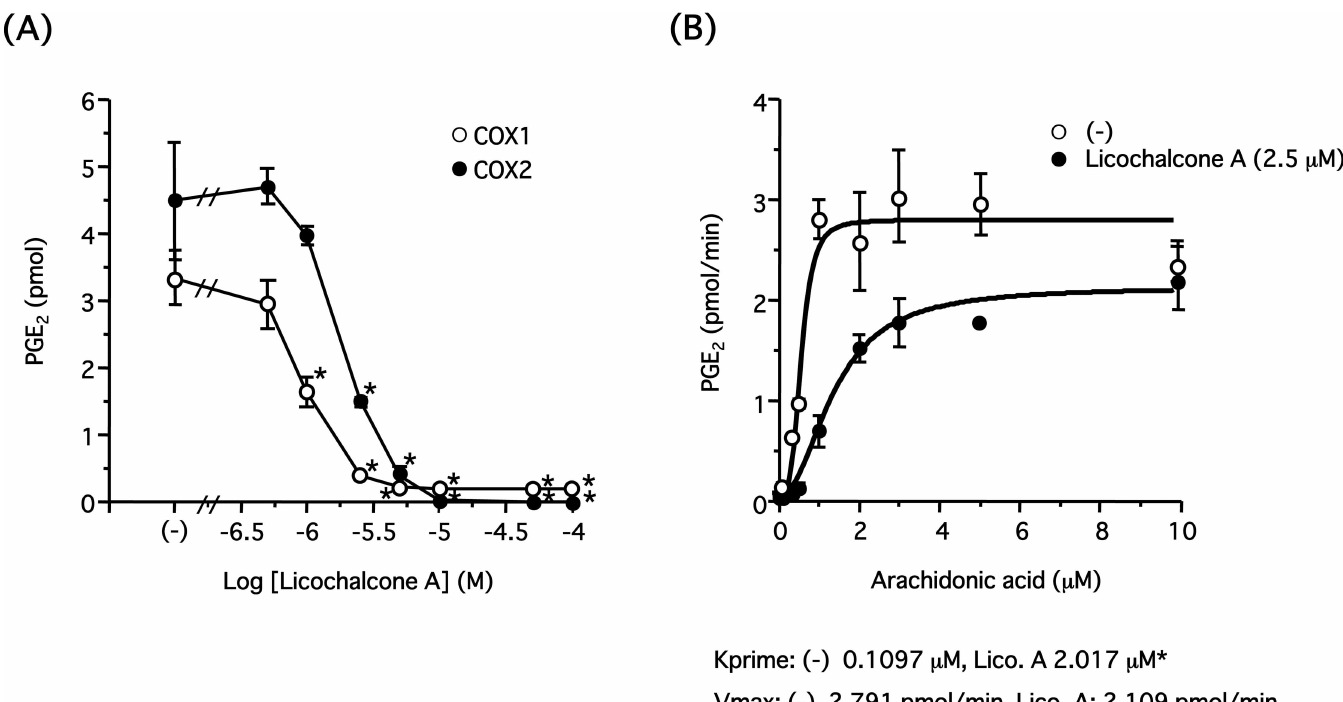
Fig 6. Competitive inhibition of COX-1 and COX-2 activity by licochalcone A in vitro . (A) Hematin (2 μ M) and L-tryptophan(5 mM) were added to 100 mM Tris-HCl buffer (pH 8.0), then two units of COX-1 or COX-2 and each concentration of licochalcone A (0.5–100 μ M) were added and incubatedat 37˚C for 10 min. The reactionwas initiatedby addingarachidonic acid (0.5 μ M). After 2 min, the reaction was terminated by adding1.0 M HCl, and then the amount of PGE 2 was measuredby LC-MS/MS. Results are shownas mean ± S.E.M. ( * P < 0.05comparedwith control, n = 3, Dunnett’smethod). (B) Two units of COX-1 and licochalcone A (2.5 μ M) were incubatedat 37˚C for 10 min as describedabove. The reaction was initiated by addingeach concentration of arachidonicacid (0.1–10 μ M). After 2 min, the reactionwas terminated by adding1.0 M HCl, and then the amount of PGE 2 was measuredby LC-MS/MS. Results are shown as mean ± S.E.M. ( * P < 0.05comparedwith control, n = 3, Student’s t-test).